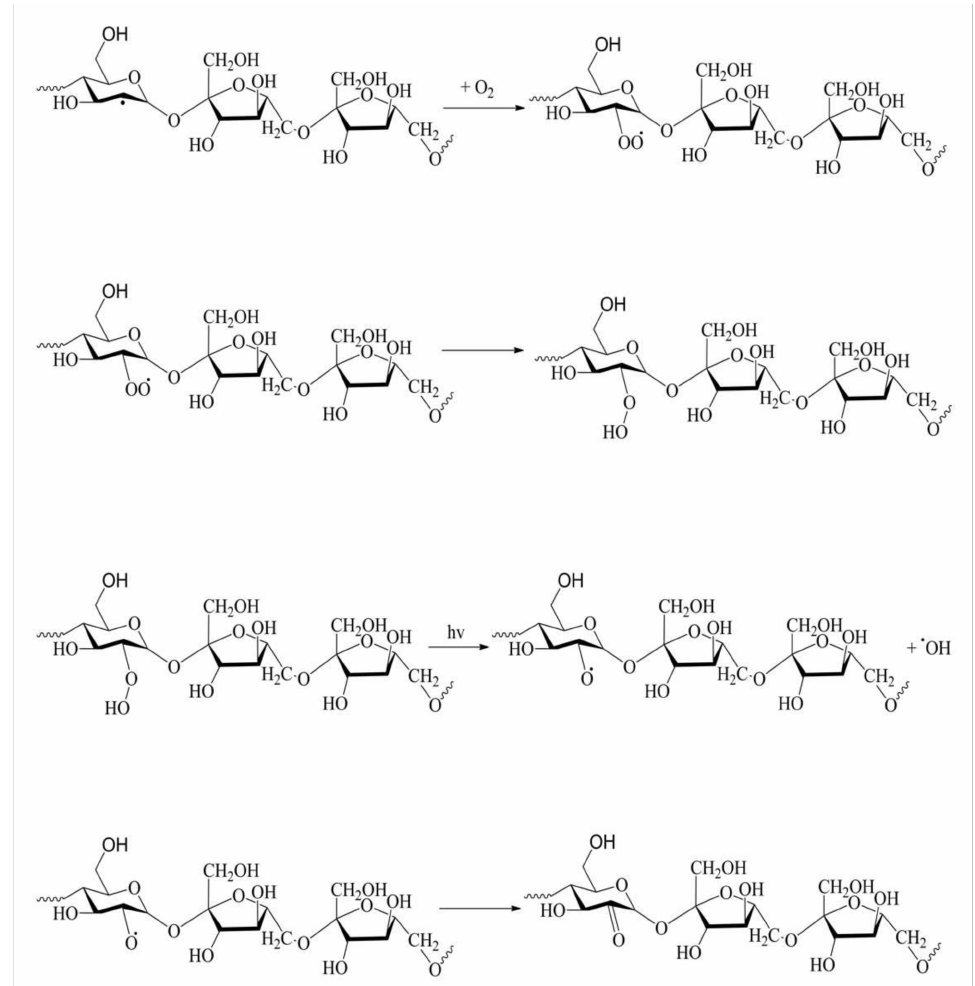
Figure 7. The photo-oxidation process of one of the levan radicals is secondarily formed during